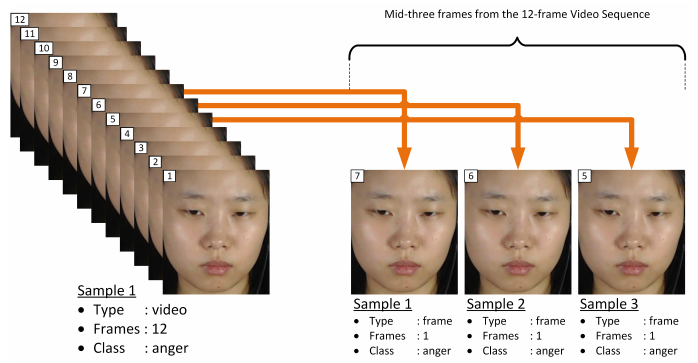
Figure 5. Illustration of video to frame sampling for Experiment